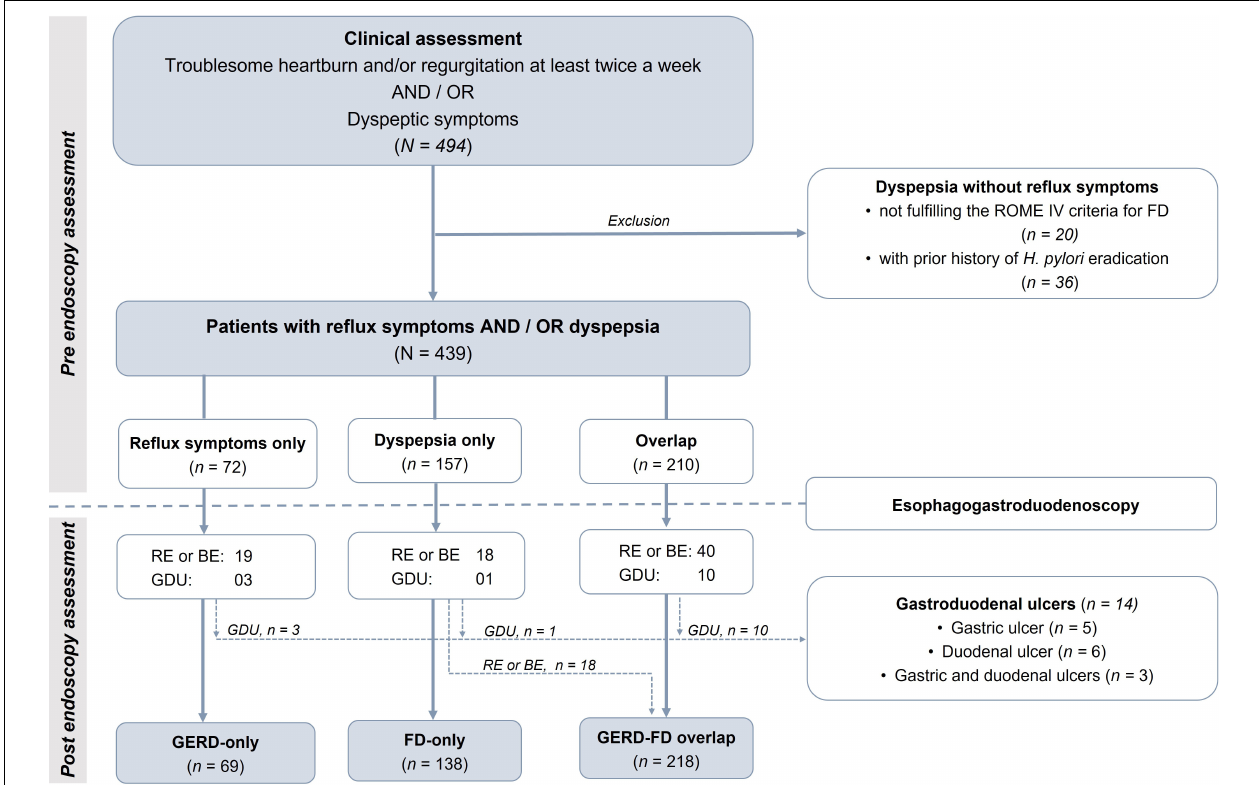
FIGURE 1 | Assessment and classifications of recruited patients before and after endoscopy. FD, functional dyspepsia; GERD, gastroesophageal reflux disease; RE, reflux esophagitis; BR, Barrett’s esophagus; GDU, gastroduodenal ulcer.